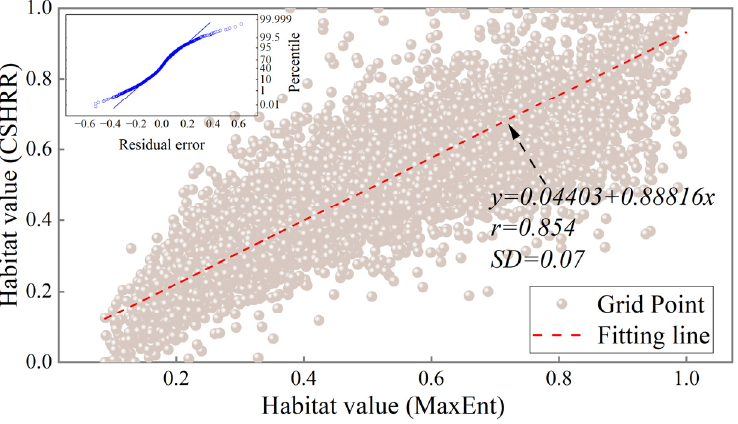
Figure 11. Vegetation habitat fi tt ing in Dongting Lake basin.